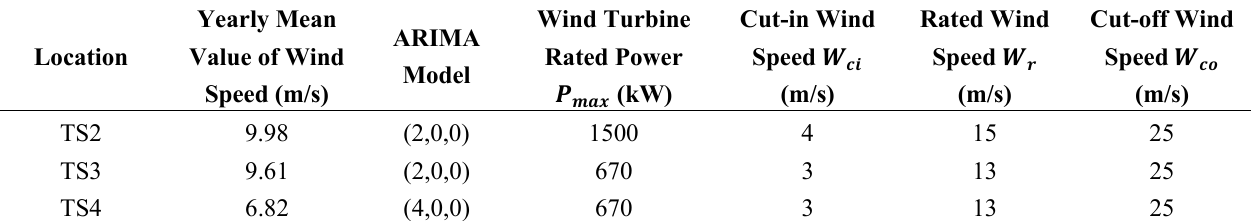
Table 4. Values of yearly mean wind speed and characteristics of the wind turbines for TS2, TS3, and TS4.